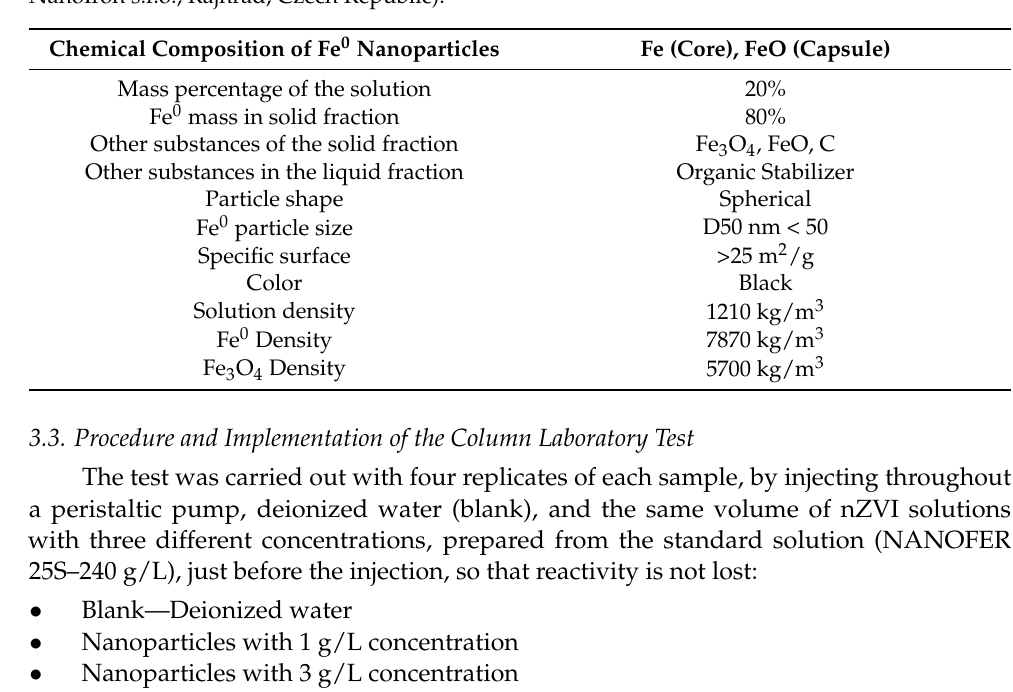
Table 1. Specifications of zero-valent iron nanoparticle solution used in the test (NANOFER 25S ® , NanoIron s.r.o., Rajhrad, Czech